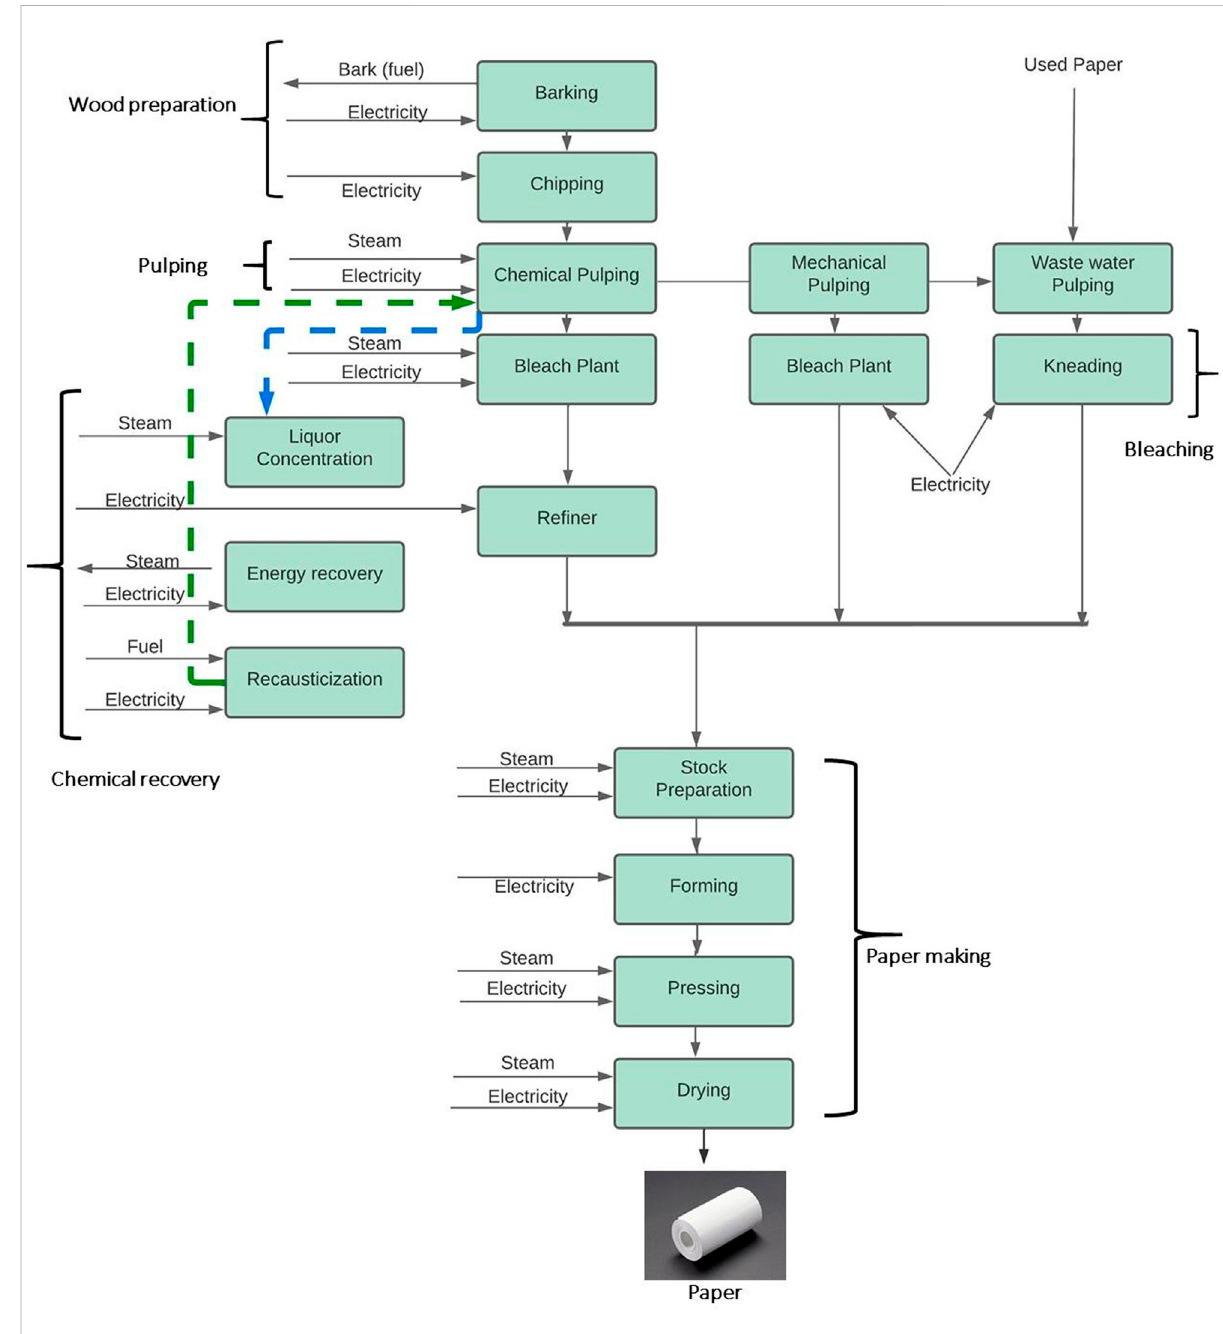
FIGURE 1 Production fl ow chart of pulp-and-paper